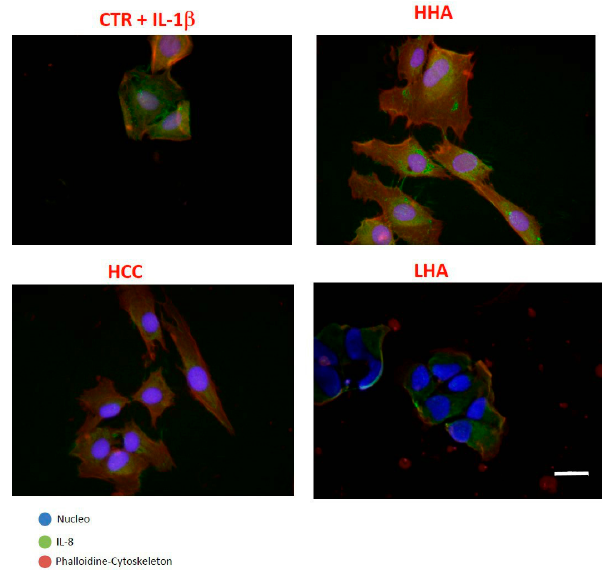
Figure 5. Expression of IL-8 in HaCat/HDF co-culture. Cells were stimulated with IL-1 β for 2 h and then treated with HHA, LHA, and HCC at 0.4% w / w , as well as a control for comparison. Images were taken 24 h after treatment. The panels show triple immunofluorescence analysis for cytoskeleton (red), nucleus (blue), and interleukin (green). In the presence of HCCs, the expression of IL-8 decreased. Scale bar represents 100 μ m.